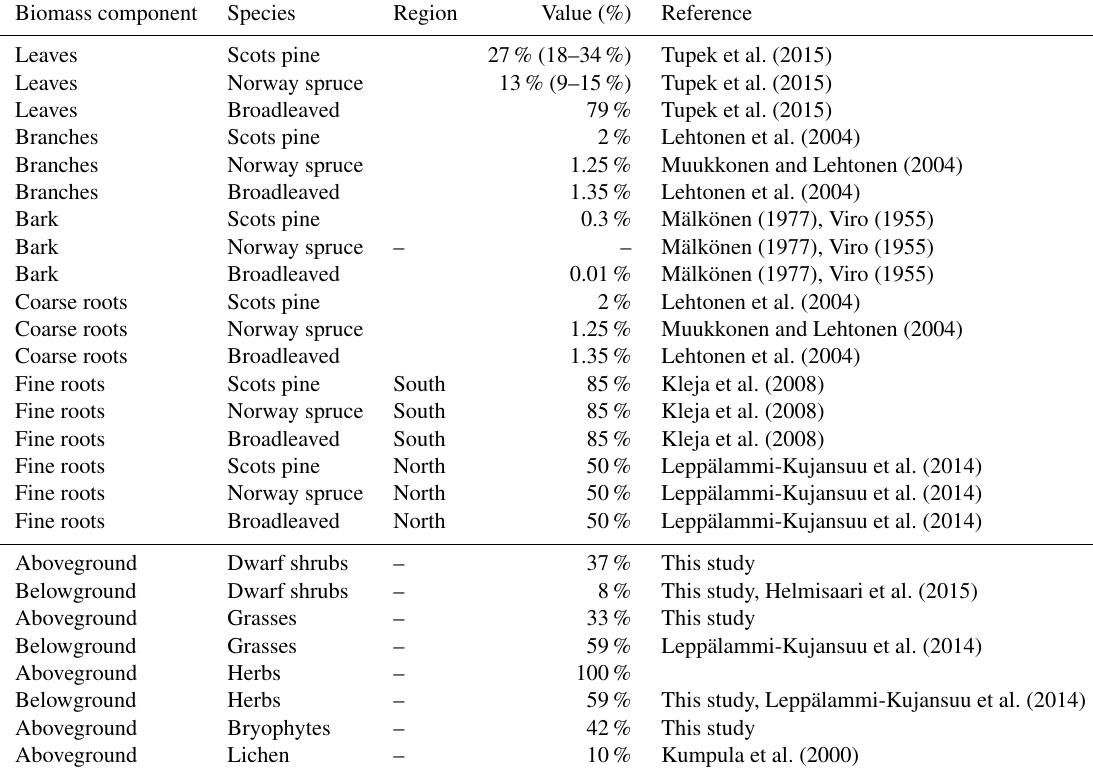
Table 2. Litter turnover rates for tree and understorey biomass by component, species and region. Biomass